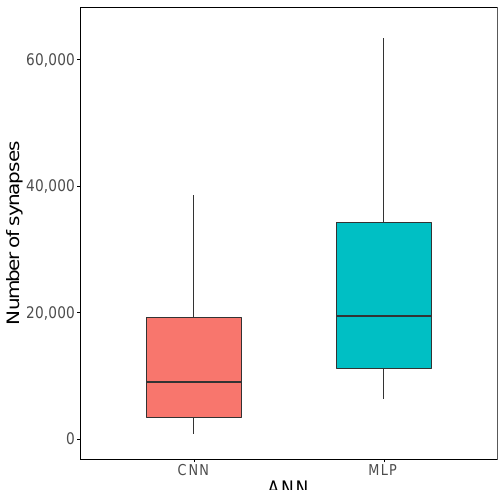
Figure 5. Distribution of total number of synapses for each type of artificial neural network (ANN). The boxplots show a rectangle where its bottom line corresponds to the 25th percentile (or first quartile), the top line to the 75th percentile (or third quartile) and the middle line to 50th percentile or median (the middle value). The vertical line below the box extends until the 0th percentile (the lowest data point excluding outliers), while the vertical line above the box extends until 100th percentile (the largest data point excluding outliers). In this figure, outliers were removed for visualization enhancement.